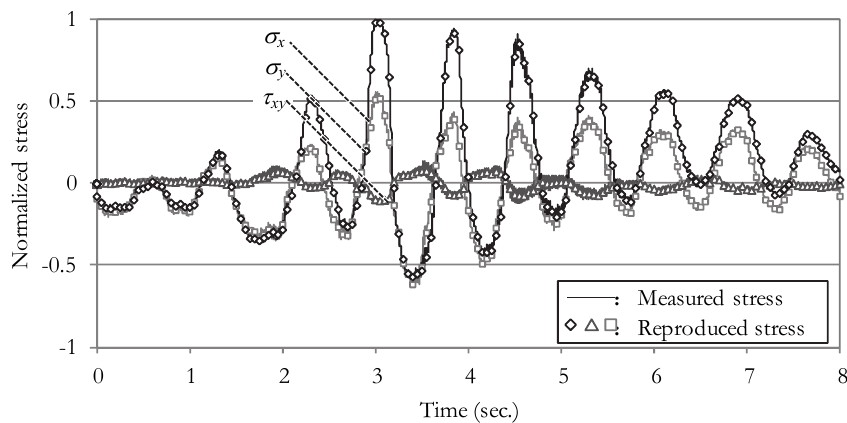
Figure 5: Comparison between reproduced and measured